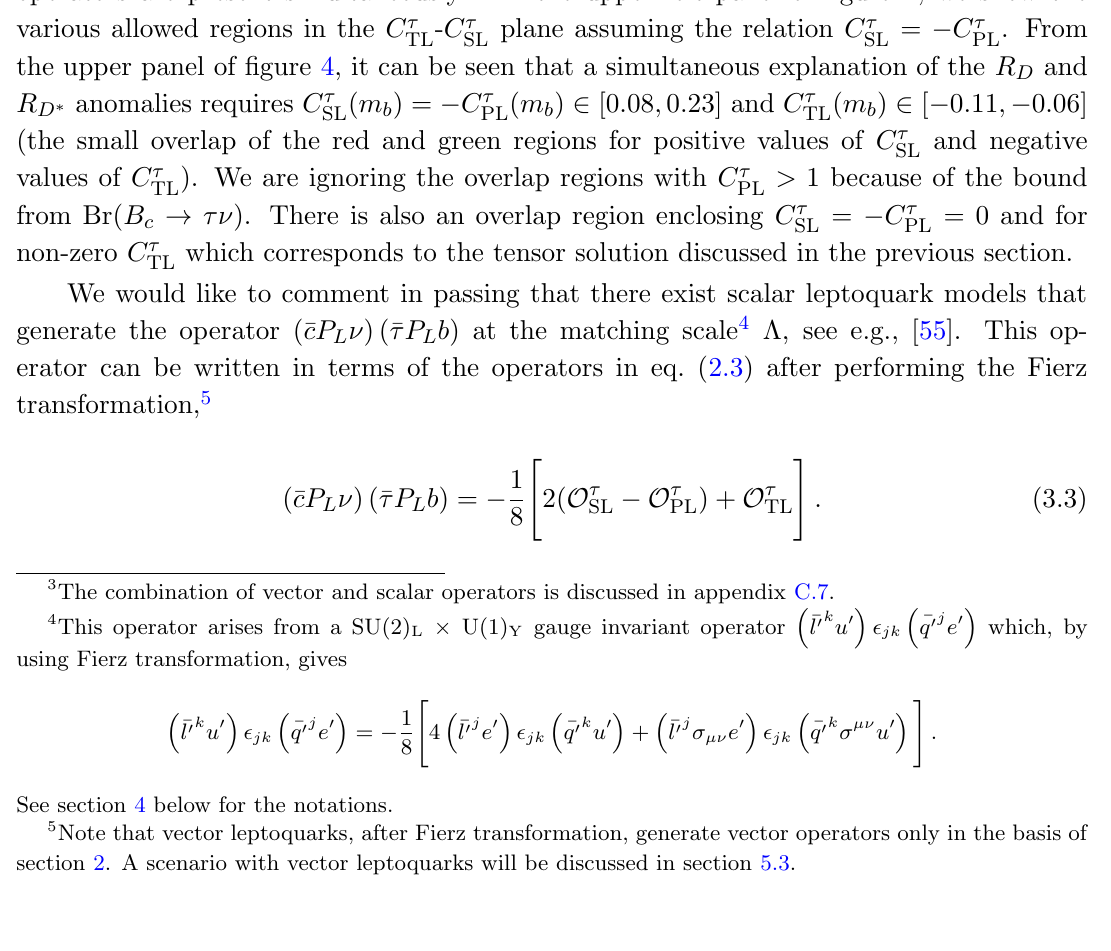
Figure 4 . The red and green (blue) shaded regions in the left panel correspond to the values of C (cid:28) = (cid:0) C (cid:28) and C (cid:28) that satisfy the experimental measurement of R D and R D (cid:3) ( R SL PL TL 1 (cid:27) respectively. The small overlap of the red and green regions for positive (negative) values of C (cid:28) ( C (cid:28) ) is magni(cid:12)ed separately in the middle panel. The right panel shows the RG evolution of the TL coupling ratio C (cid:28) =C (cid:28) assuming C (cid:28) =C (cid:28) = 2 at 3 TeV. See text for more SL TL SL TL